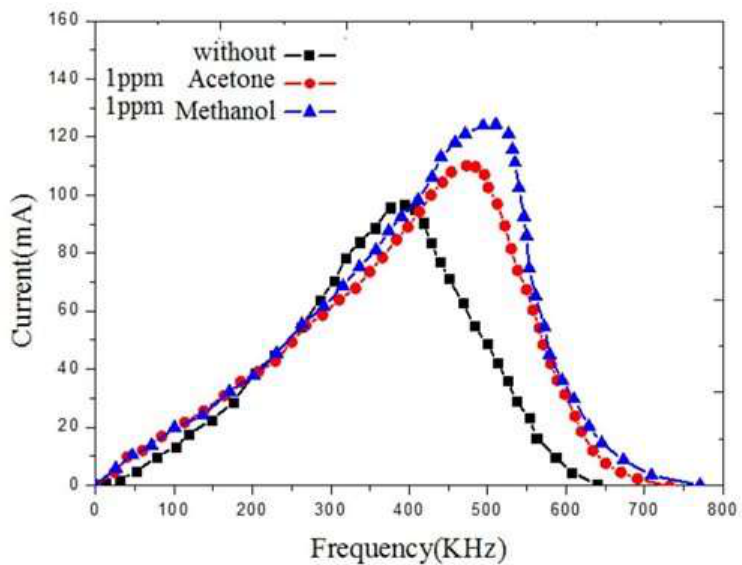
Figure 7: Current-Frequency properties of impedance matching circuit of organic vapors, (a) S 1 , (b) S 2, and (3) S 3 sensors at (0.1 ppm) concentration of methanol and